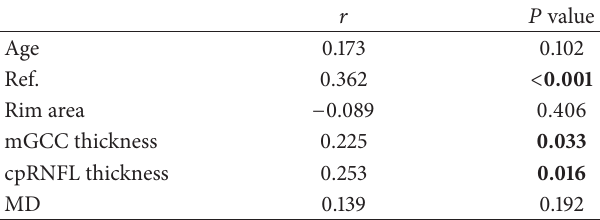
Table 2: Correlations of the ONH area with other factors.